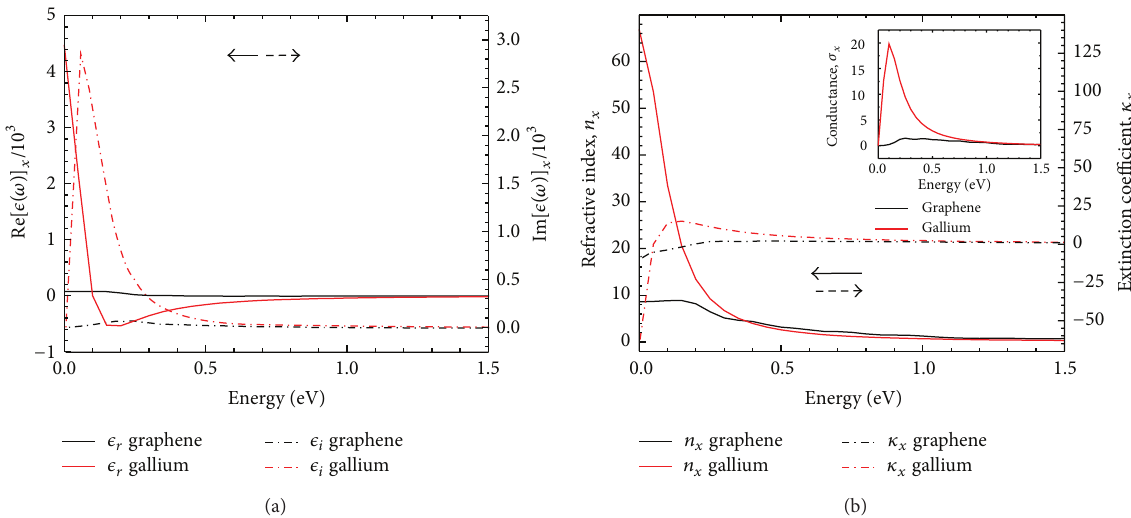
Figure 4: (a) Simulated dielectric response as a function of energy for a pure graphene sheet and a theoretical gallium sheet. (b) The calculated refractive index and extinction coefficient as functions of energy, where the conductance is placed in the inset.